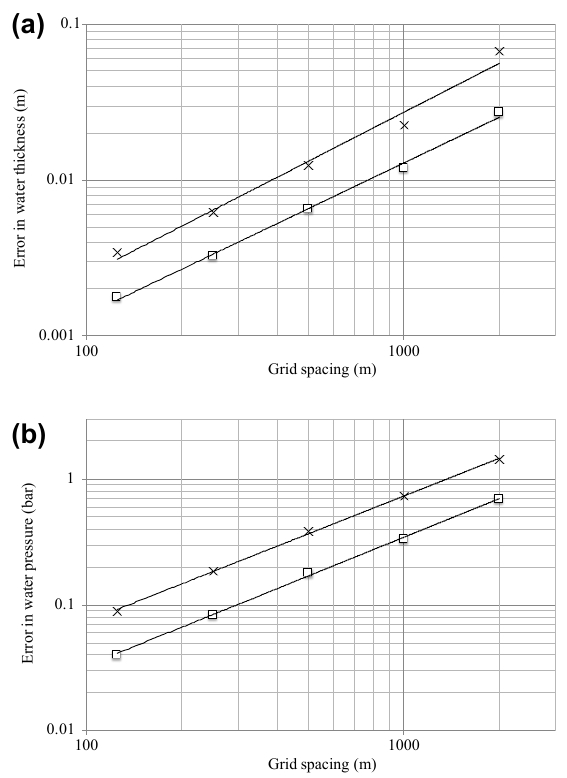
Figure 3. Error in subglacial hydrology model for radial test case with the near-exact solution described by Bueler and van Pelt (2015) for different grid resolutions. (a) Error in water thickness; x sym- bols indicate maximum error, and squares indicate mean error. Av- erage error in water thickness decays as O ((cid:49)x 0 . 97 ) . (b) Error in water pressure, with same symbols. Average error in water pressure decays as O ((cid:49)x 1 . 02 )